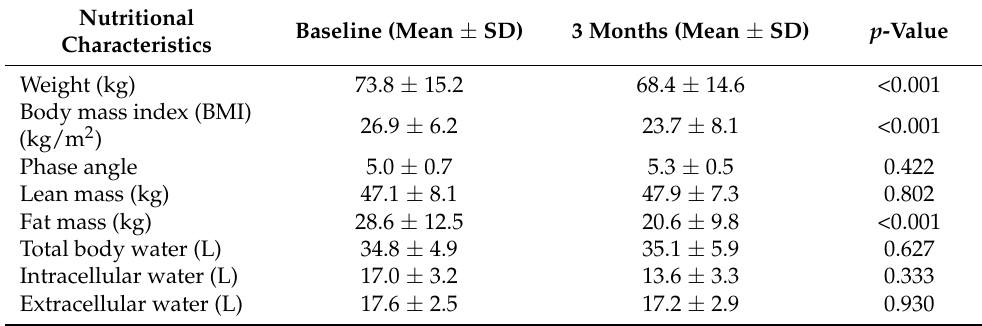
Table 3. Patients’ nutritional characteristics before and after 3 months of